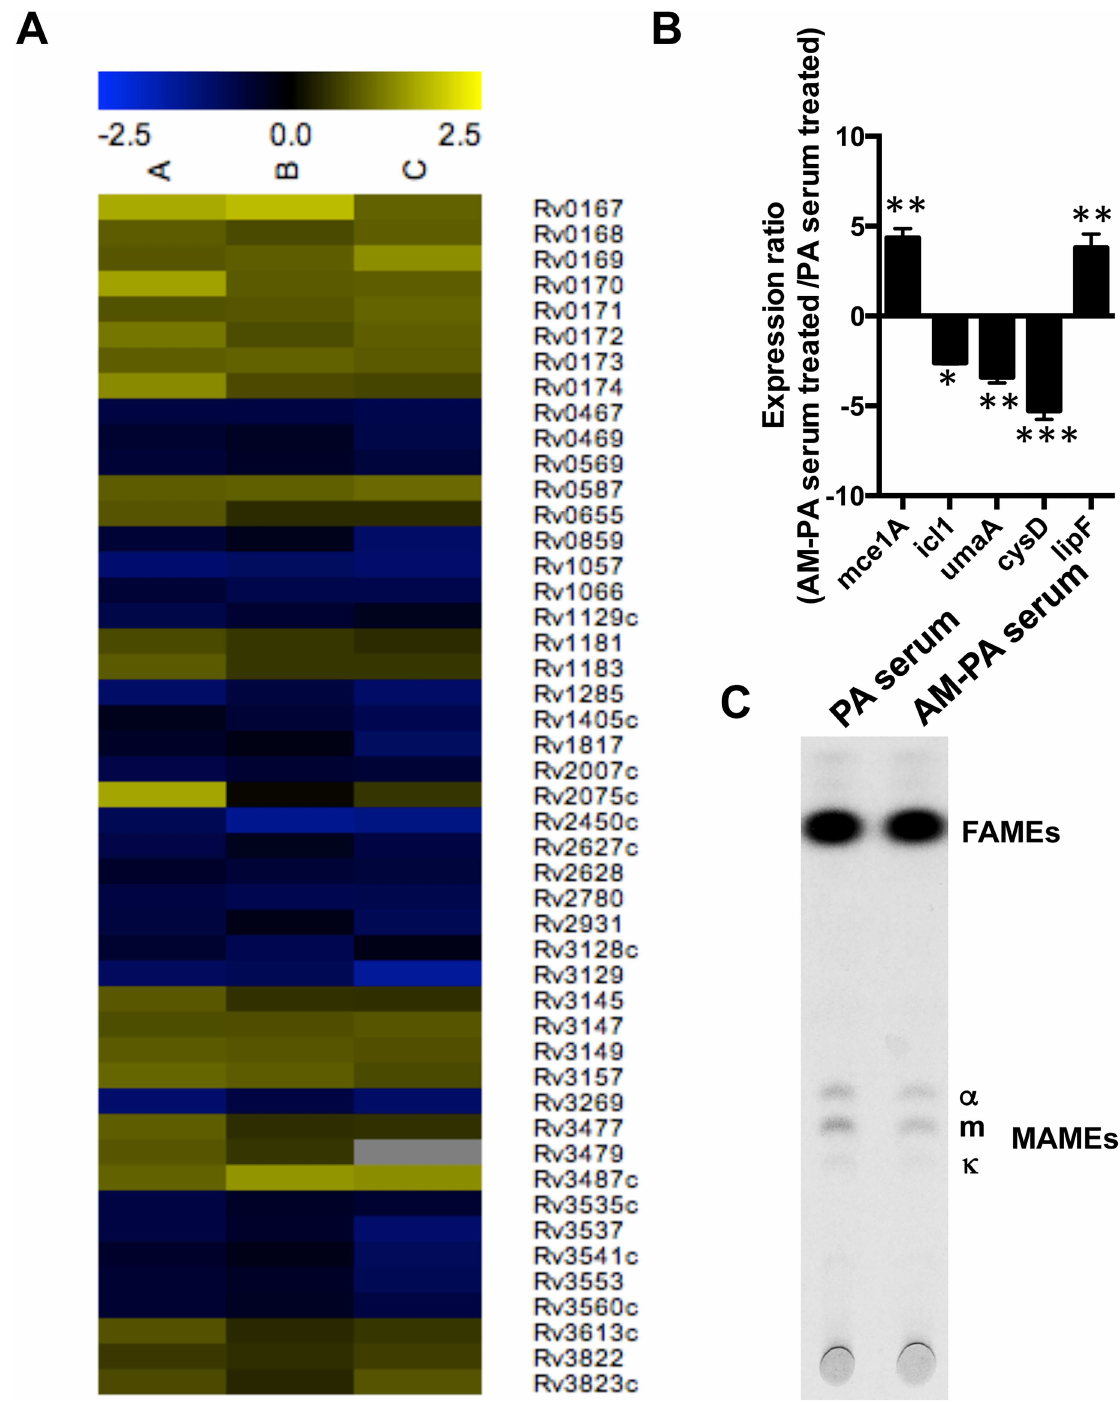
Fig 3. Effect of AM immune serumon the transcriptional profile of M . tuberculosis .(A) Transcriptomic profileof Mtb during treatmentwith AM-PA murineserum(1:400)compared to PA murineserum (1:400)for 4 h. The heat mapshowstranscriptional changesfrom three biologically independent replicates labelledas A, B andC. (B) Expressionratio of the indicatedMtb genes measured as the averagerelativeexpression of AM-PA serum vs PA serum-treated Mtb by quantitativerealtime PCR (qRT-PCR). ( * P < 0.05, ** P < 0.01 *** P < 0.001,one-wayANOVA withTukey post-test). (C) Analysisof fatty acidmethylesters (FAMEs) and mycolicacidmethylesters (MAMEs) in M . tuberculosis H37Rvlabelledwith 14 C-acetatefor 22hpriorto treatmentwith the indicated serum preparationsfor 5 h. Lipidswereextractedandanalyzedby TLC as describedin Methods.The sameamountof cpm was spottedfor eachsample. https://doi.org/10.1371/journal.ppat.1006250.g003 PLOS Pathogens| https://doi.org/10.1371/journal.ppat.1006250 March 9,